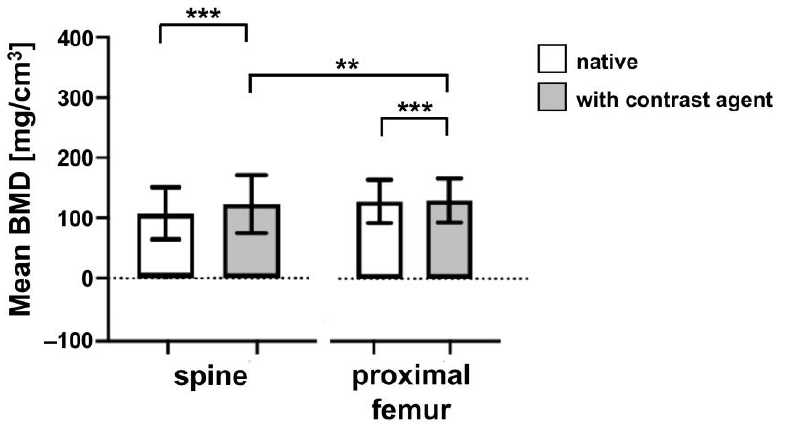
Figure 2. Comparison of bone mineral density (BMD) with and without contrast agent administration. Distribution of BMD of spine patient cohort (n = 127) and proximal femur patients (n = 70); white bars represent the BMD in native CT, gray bars indicate BMD in CT diagnostics after contrast agent application. BMD of patients in mg/cm 3 shown on the y-axis, localization of BMD shown on the x -axis. *** = <0.001; ** = <0.003. Median values are shown. Table 1. Overview of populations